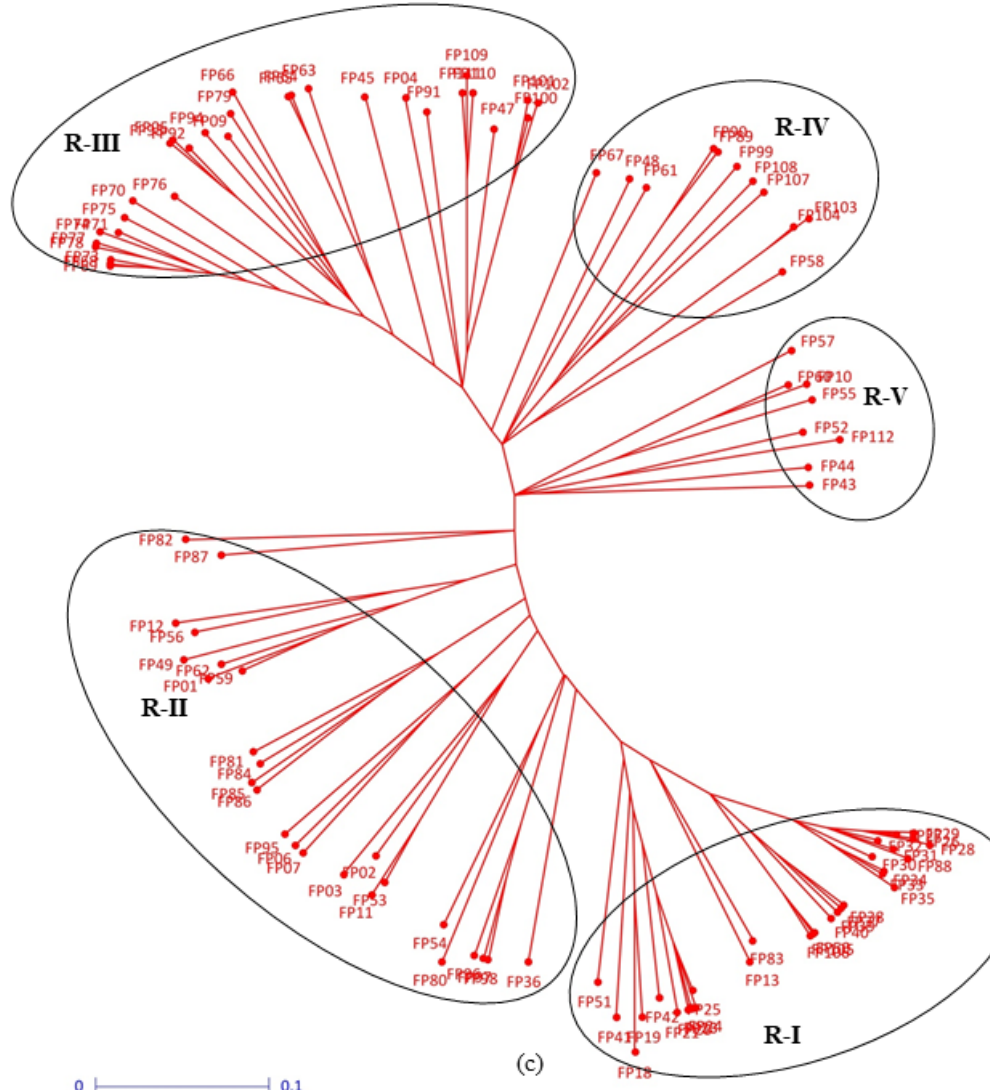
Figure 2. Neighbor joining tree based on 7870 GBS-identified SNPs: ( a ) 122 seed and pollinator parents; ( b ) 18 seed parents; and ( c ) 104 pollinator parents.